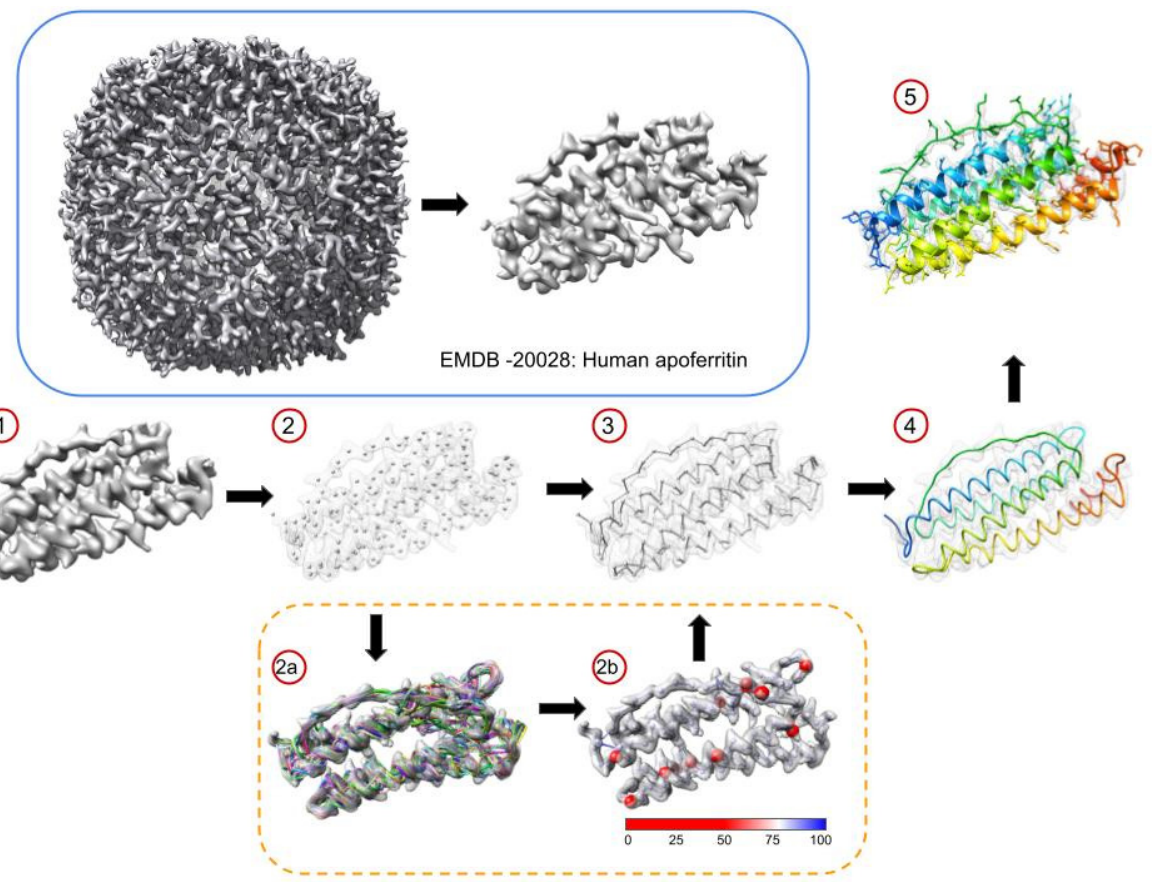
Figure 1. Pathwalking. The basic steps of Pathwalking using EMD-20028, human apoferritin at 3.1 Å resolution, are shown. In the blue box, the reconstruction of apoferritin is shown with a single monomer segmented from the density map. In ( 1 ), the map is low-pass-filtered to ~4.5 Å resolution, which is then followed by pseudoatom generation ( 2 ). An initial trace is computed using a TSP solver in ( 3 ) and then refined to optimally fit the density and remove any non-protein-like features ( 4 ). Finally, the sequence is threaded onto the model, from which a full atom model is generated and real-space-refined using the original segmented density map ( 5 ). The new version of Pathwalking has the option to generate a set of decoy models from which a probabilistic model can be calculated (dashed orange box). In ( 2a ) 100 separate paths over 5 thresholds and 20 noise levels were calculated using Pathwalking. In ( 2b ), an average model from the 100 paths is shown. Connections are colored based on probability that pseudoatom N is connected to N + 1 and N − 1 in all 100 models. Red spheres indicate instances where the connection probability was below 50%.